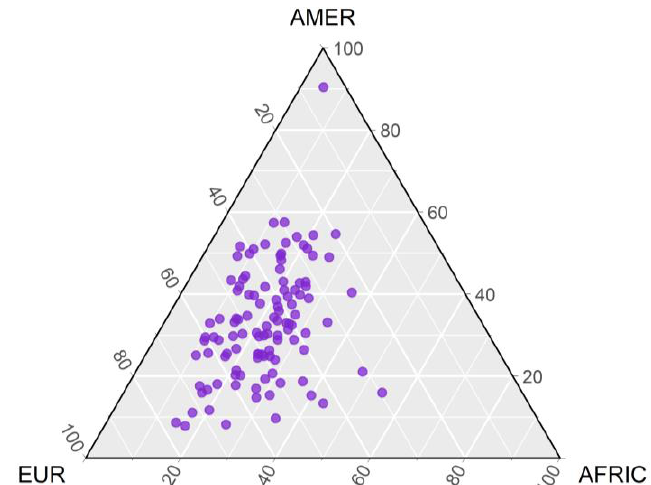
Figure 1. Representation of individuals’ inter-ethnic admixtures. Patients with ALL are represented by a dot in purple and their location on the graph corresponds to the mixture ratios. The mixture is estimated by comparison with parent populations of individuals represented in the triangle vertices: European (EUR), Amerindian (AMER), and African (AFRIC).